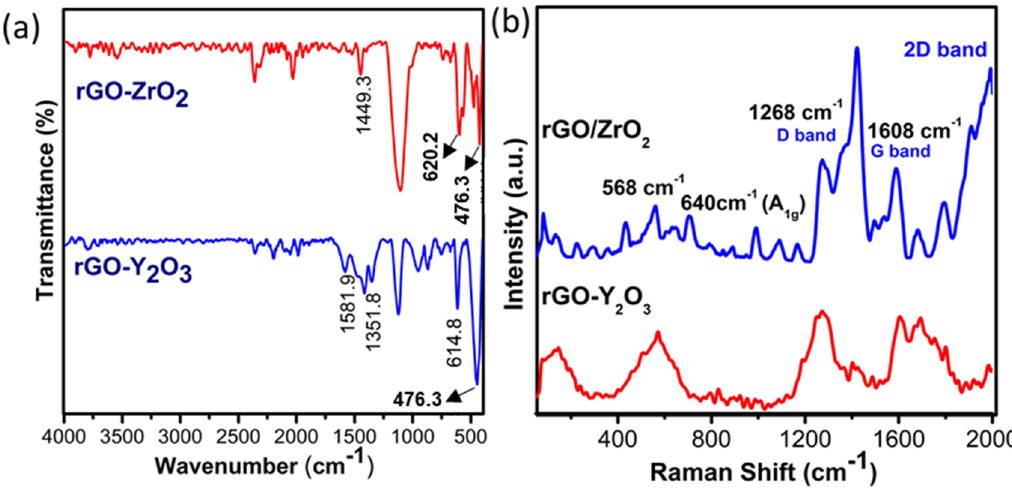
Figure 3. ( a ) FT-IR ( b ) Raman spectra of rGO-ZrO 2 and rGO-Y 2 O 3 nanocomposites. UV-visible absorption spectroscopy is a non-destructive tool used to determine the and rGO-Y 2 O 3 samples were characterized by solid-state absorption in the wavelength range of 800 nm to 200 nm. Both rGO-ZrO 2 and rGO-Y 2 O 3 nanocomposites showed strong and broad absorption, whereas the bare Y 2 O 3 and ZrO 2 showed weak absorption, as shown in Figure 4. The broad absorption of nanocomposite is due to the π → π * transitions of the C = C bond present in the sample; this criterion is also applicable for the samples. The band gap of the rGO-ZrO 2 and rGO-Y 2 O 3 nanocomposites is determined by the ab- sorption value of the corresponding samples. It shows the band gap value of 2.56 and 2.78 eV for rGO-ZrO 2 and rGO-Y 2 O 3 nanocomposites, respectively (inset of Figure 4b). The narrow band gap of the nanocomposites is due to shifting the valance band/conduction band position by using reduced graphene oxide. Thus, the obtained nanocomposites were expected to show an improved photoactivity under simulated light irradiations. Figure 4. ( a )UV-Visible spectra of rGO-Y 2 O 3, rGO-ZrO 2 , Y 2 O 3 and ZrO 2 ( b ) UV-DRS spectra of rGO- Y 2 O 3, rGO-ZrO 2 . Inset Tauc plot of rGO-Y 2 O 3, rGO-ZrO 2 .